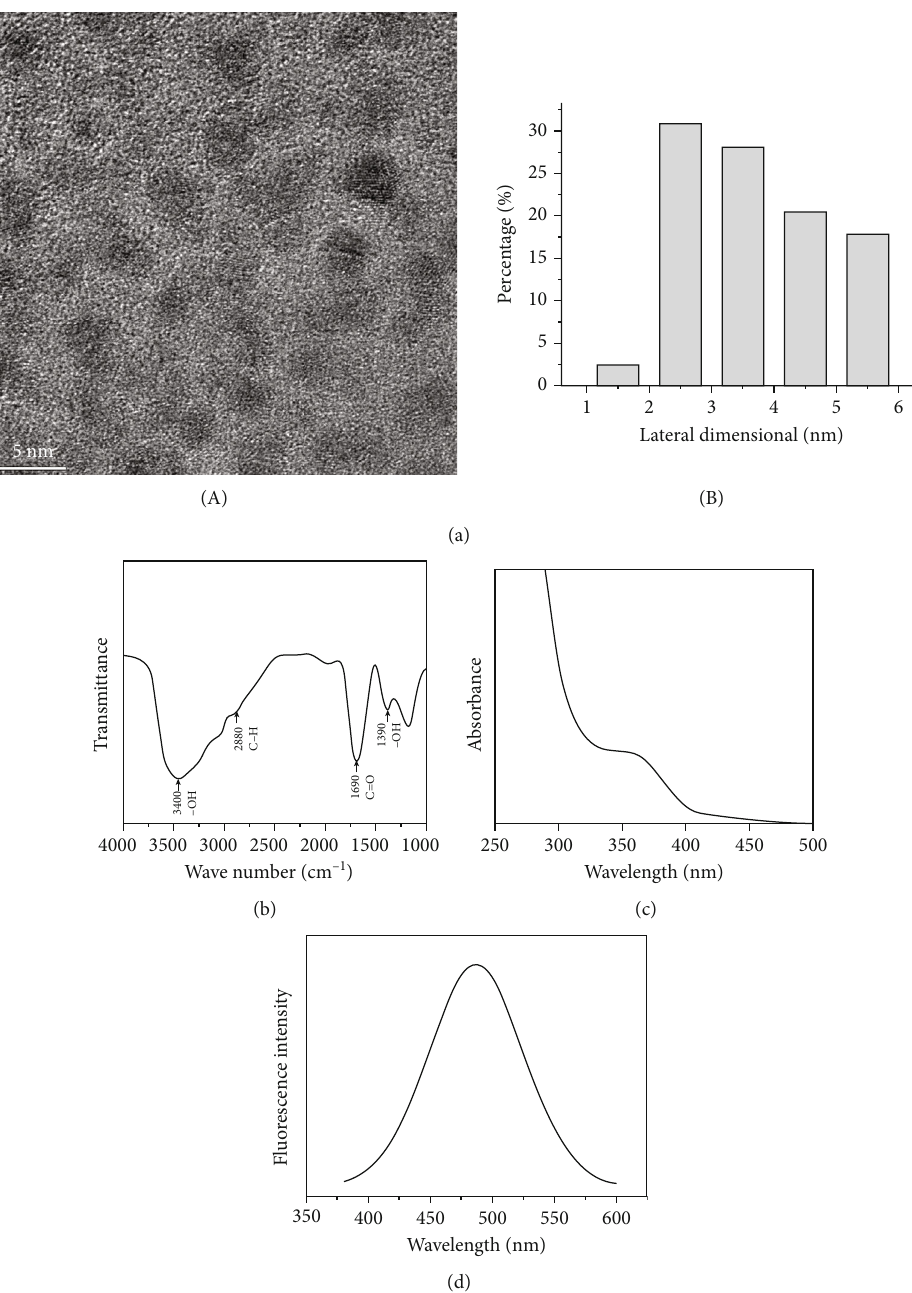
Figure 1: Characterization of GOQDs. (a) (A) TEM image of GOQDs. (B) Lateral size distribution of GOQDs from (A). (b) FTIR spectroscopy of GOQDs. (c) UV-visible spectrum of GOQDs. (d) PL spectrum of GOQDs excited at a wavelength of 365